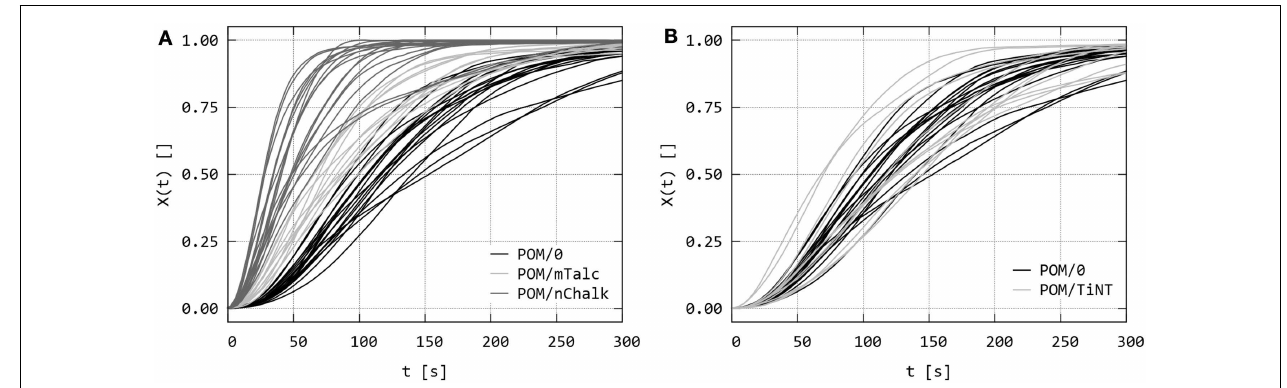
illustrated in Figures4 and 5 .The graphs compare raw X ( t ) data of (A) sandwiches POM/0 vs. POM/mTalc and POM/nChalk, and (B) POM/0 vs. POM/TiNT.